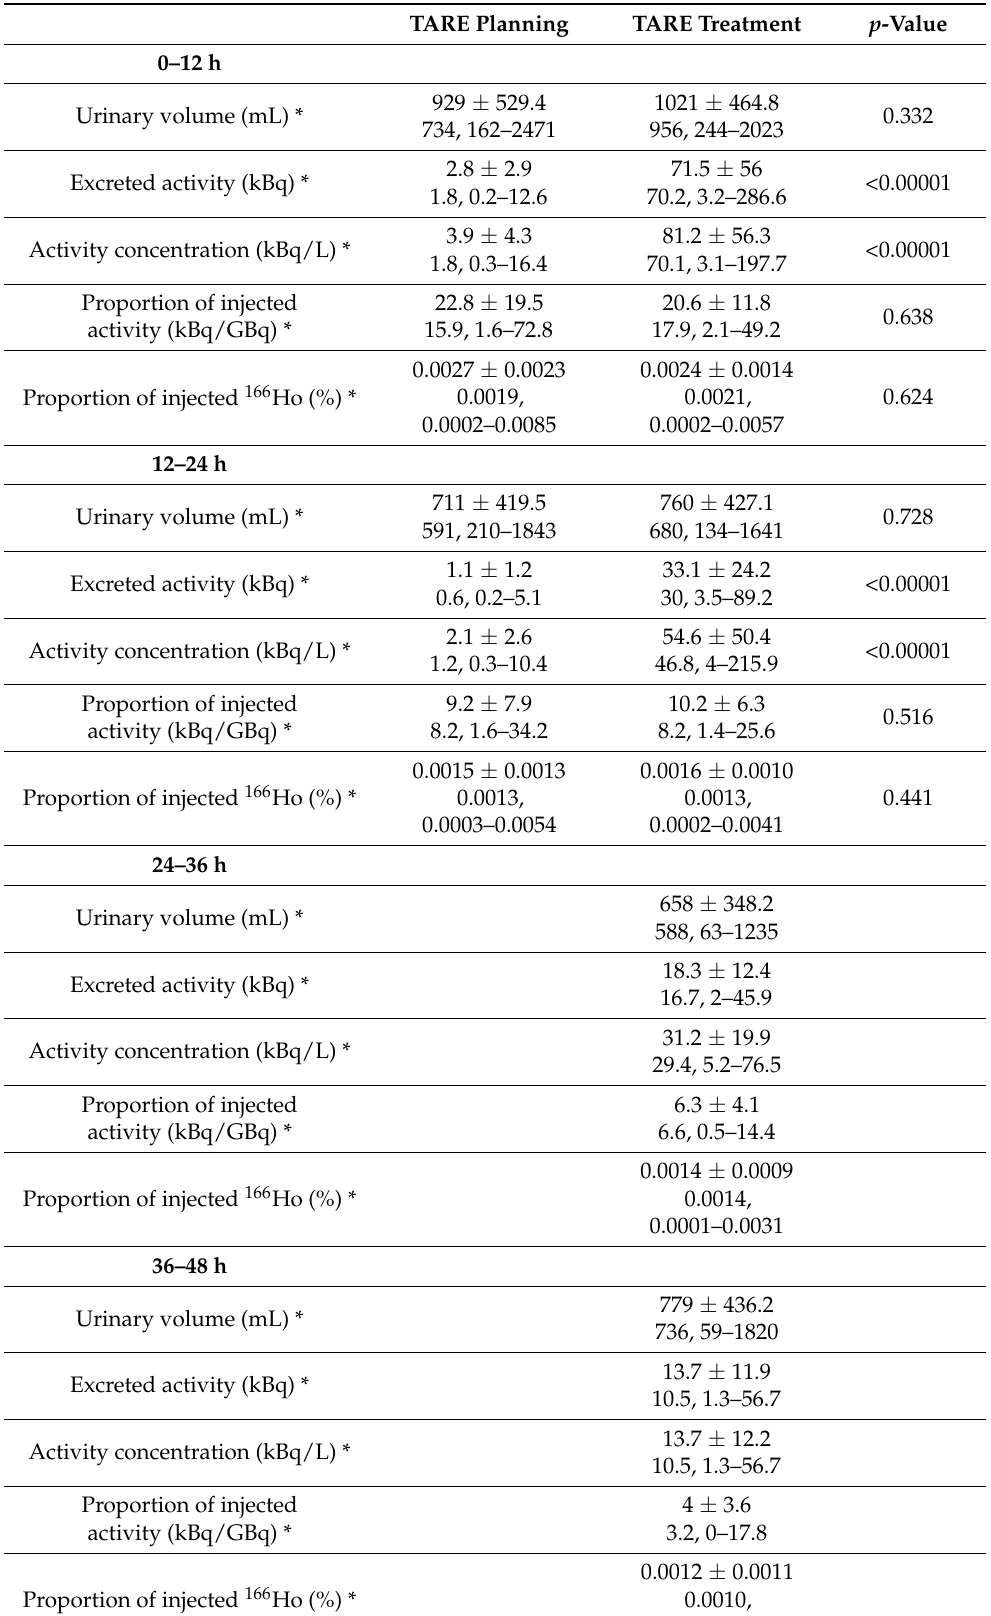
Table 2. Renal activity